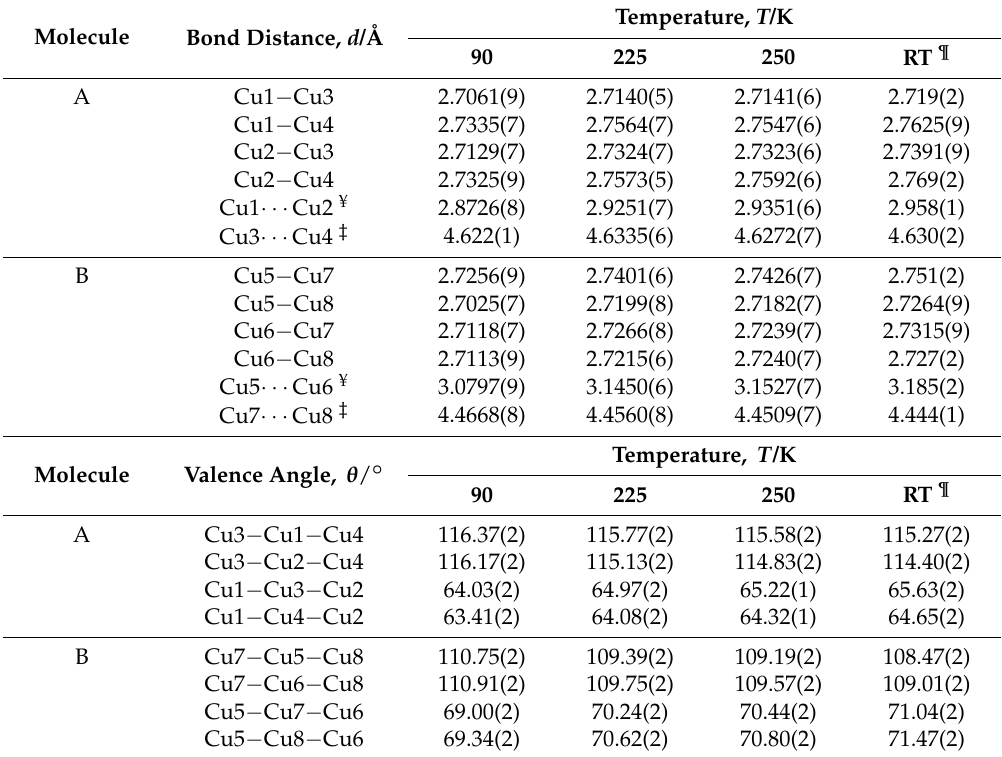
Table 1. Selected geometrical parameters describing the molecular cores of both independent molecules present in the Cu 4 crystal structure at different